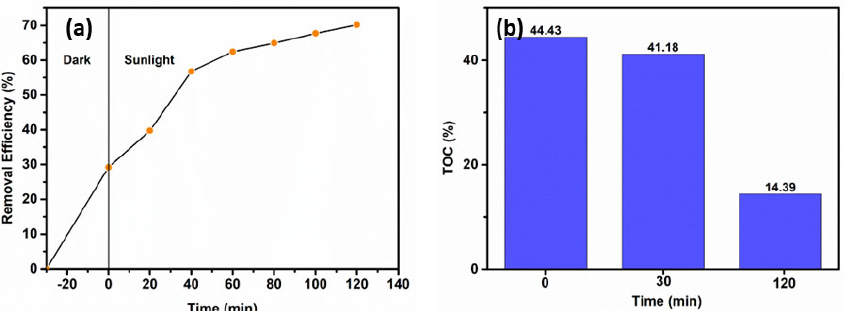
Figure 11. ( a ) The removal efficiency of CIP for TOC analysis and ( b ) the depletion in TOC value of CIP solution with respect to time (condition: 1:1 CBB composite, 1.5 g/L, and 10 ppm